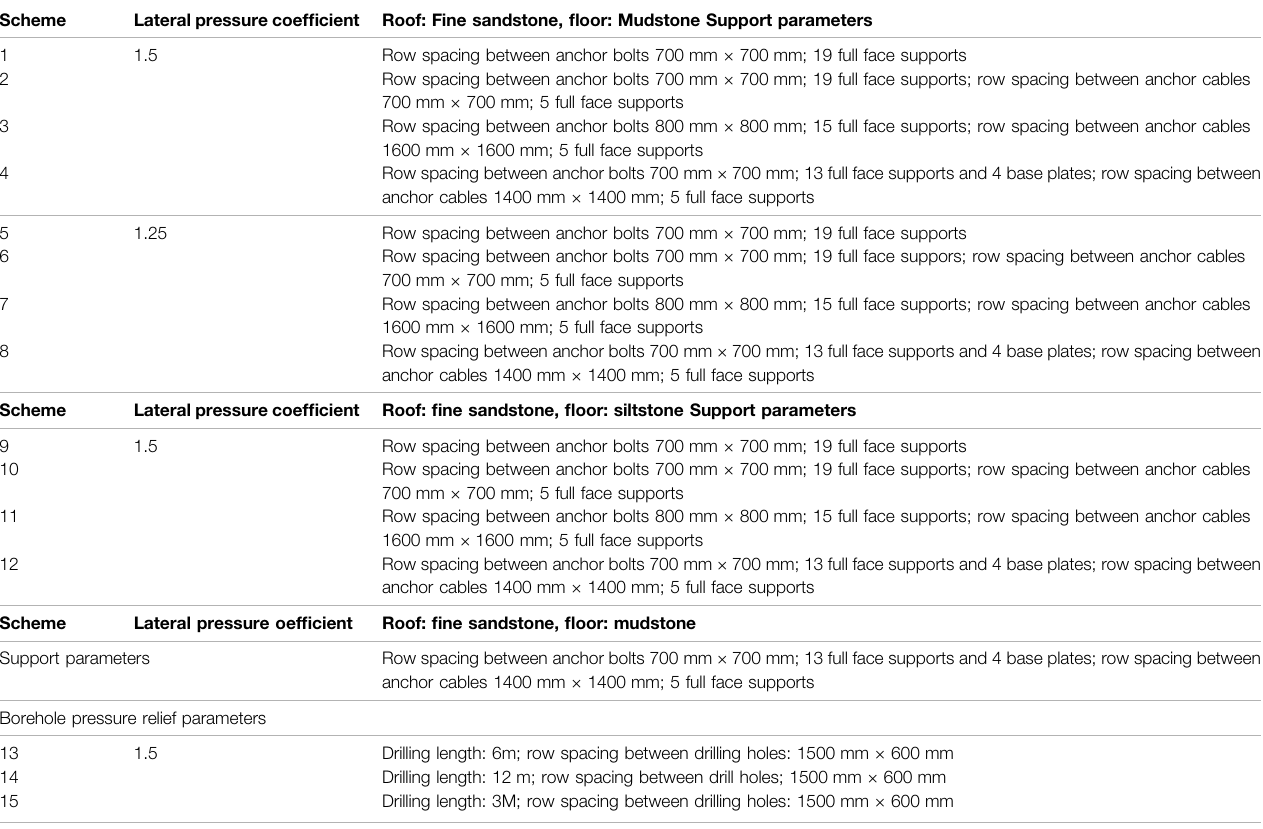
TABLE 2 | Numerical simulation scheme of the roadway surrounding rock.